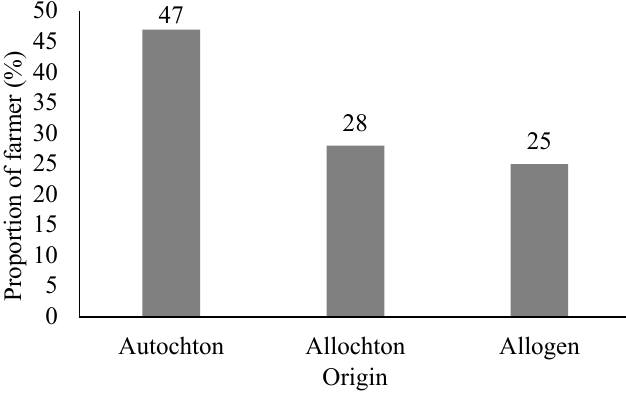
Figure 8. Distribution of cocoa farmers Biankouma region.